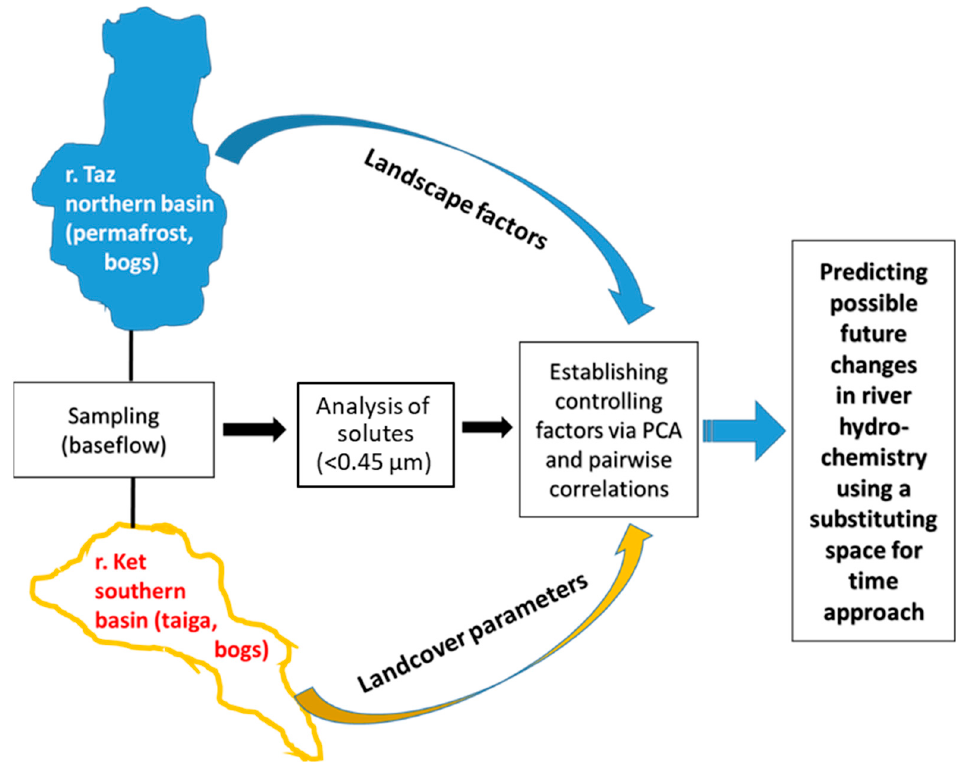
Figure 1. A flow chart of methodological approach used in the present study.